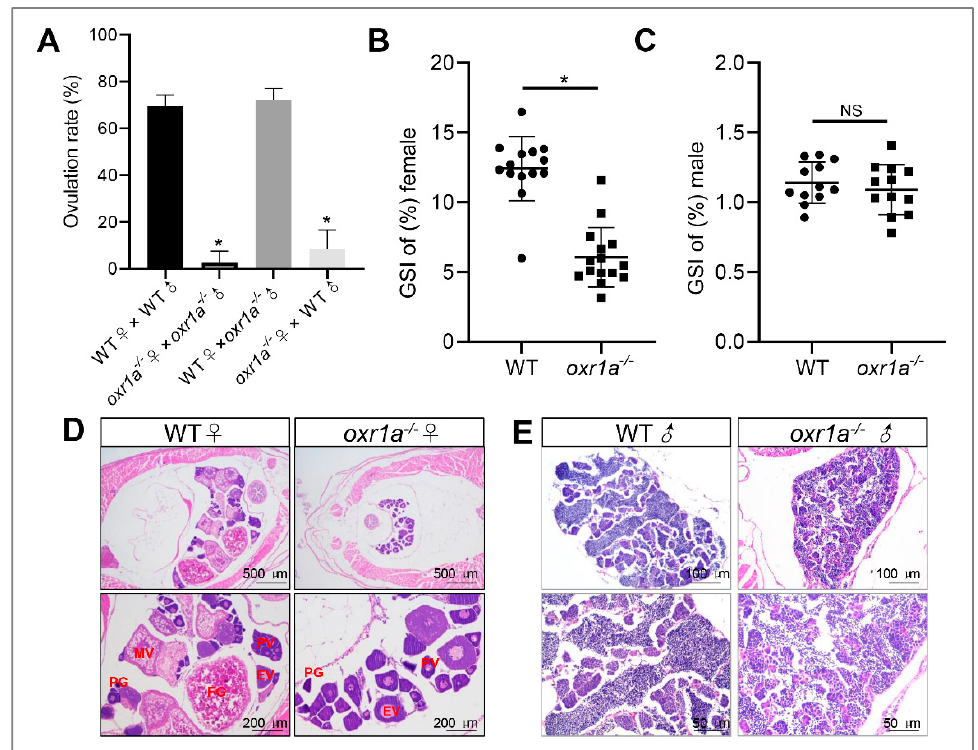
Figure 5. Oxr1a mutation impaired the fertility and induced ovarian failure in zebrafish. ( A ) A significant decline of spawning rate in oxr1a − / − mutant females at five months old. ( B , C ) The gonadosomatic index (GSI) scatterplot of WT and oxr1a − / − mutant zebrafish in both female and male zebrafish, respectively. n = 12. ( D , E ) H&E staining for histological analysis of WT and oxr1a − / − mutant zebrafish gonads. PG, PV, EV, MV and FG represent primary growth stage, previtellogenic stage, early vitellogenic stage, midvitellogenic stage and full-grown stage, respectively. * indicates significant differences ( p < 0.05), while NS indicates no significant difference ( p > 0.05).